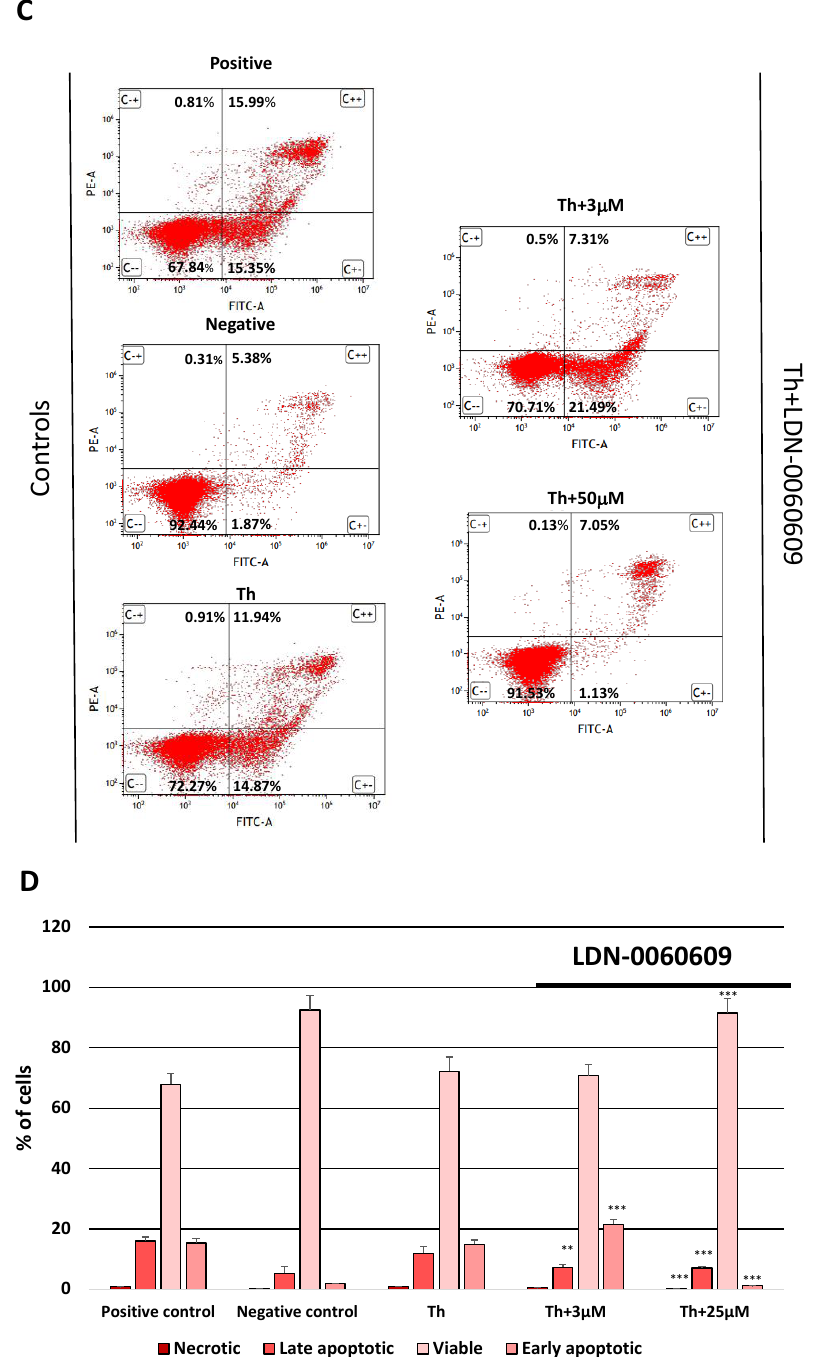
Figure 9. Analysis of apoptosis of the PERK inhibitor LDN-0060609 only ( A , B ) and after treatment of HTM cells with the Th and PERK inhibitor LDN-0060609 ( C , D ) by flow cytometric FITC annexin V/propidium iodide (PI) double staining. Dot plot graphs ( A , C ) and bar graphs ( B , D ), determined from dot plot graphs, indicate the percentage of viable (FITC annexin V negative, PI negative), early apoptotic (FITC annexin V positive, PI negative), late apoptotic (FITC annexin V positive, PI positive) and necrotic (FITC annexin V negative, PI positive) HTM cells. Each of the statistical analysis in individual experiments was based on the results of three independent tests. Data are expressed as mean ± SE (n = 3 ). On the bar graphs, the differences were statistically significant as follows: ** p < 0.01, *** p < 0.001 versus the negative control ( B ) and versus Th ( D ). DMSO—dimethyl sulfoxide;